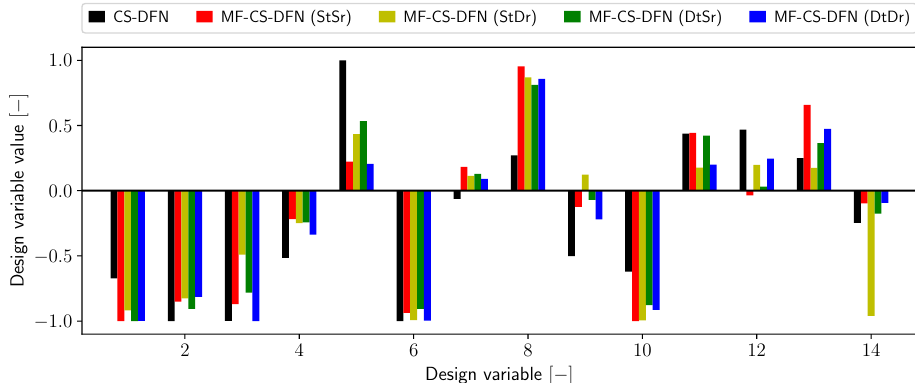
Figure 5. Variable values of the optimized hulls.